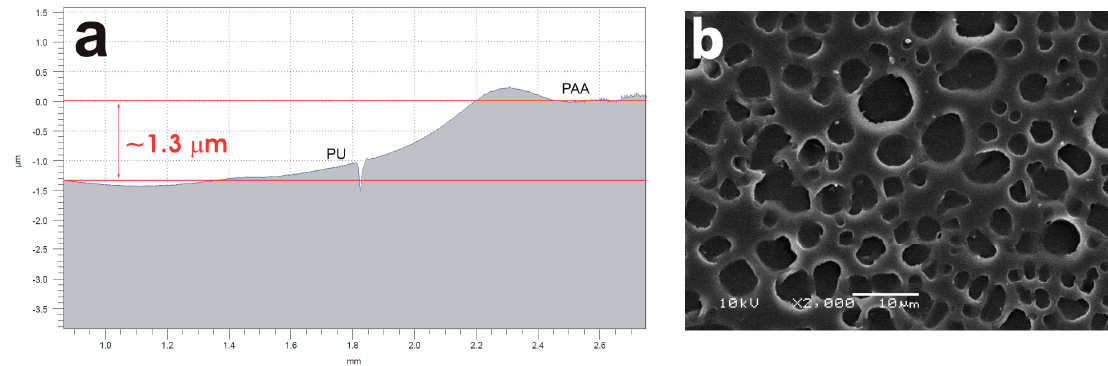
Figure 3. Profilometer cross-section of a PU film after UV irradiation in the presence of AA vapors for 30 min ( a ); SEM image of PU film irradiated with UV in the presence of AA vapors for 30 min ( b ).